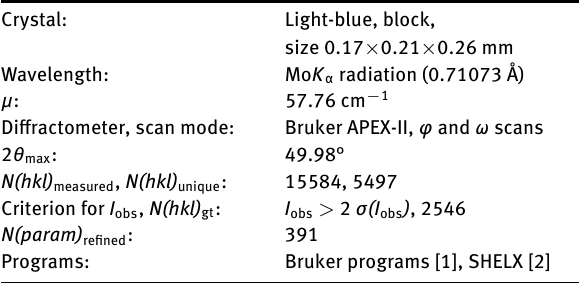
Table 2: Fractional atomic coordinates and isotropic or equivalent isotropic displacement parameters (Å 2 ).